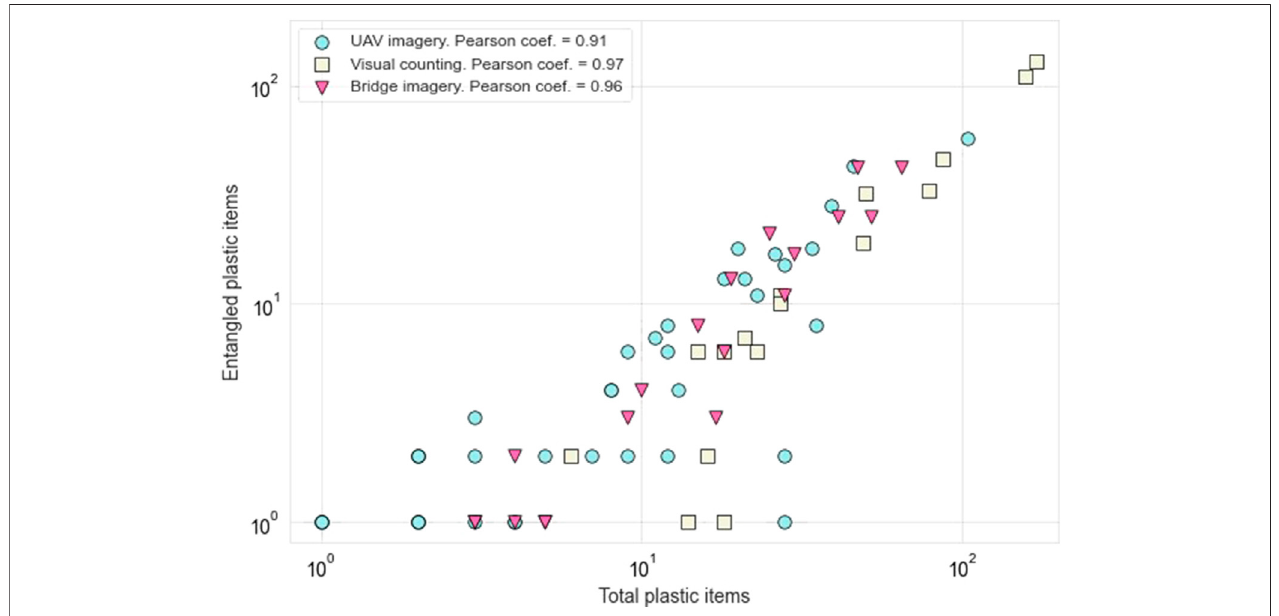
FIGURE4| Entangledplasticitems inrelation tototal fl oating macroplasticsasobservedintheSaigonrivernearThuThiembridge.Each pointcorrespondstoone observation (i.e., one visual counting measurement, one camera photograph and one UAV image). Note the logarithm scale for both axes.